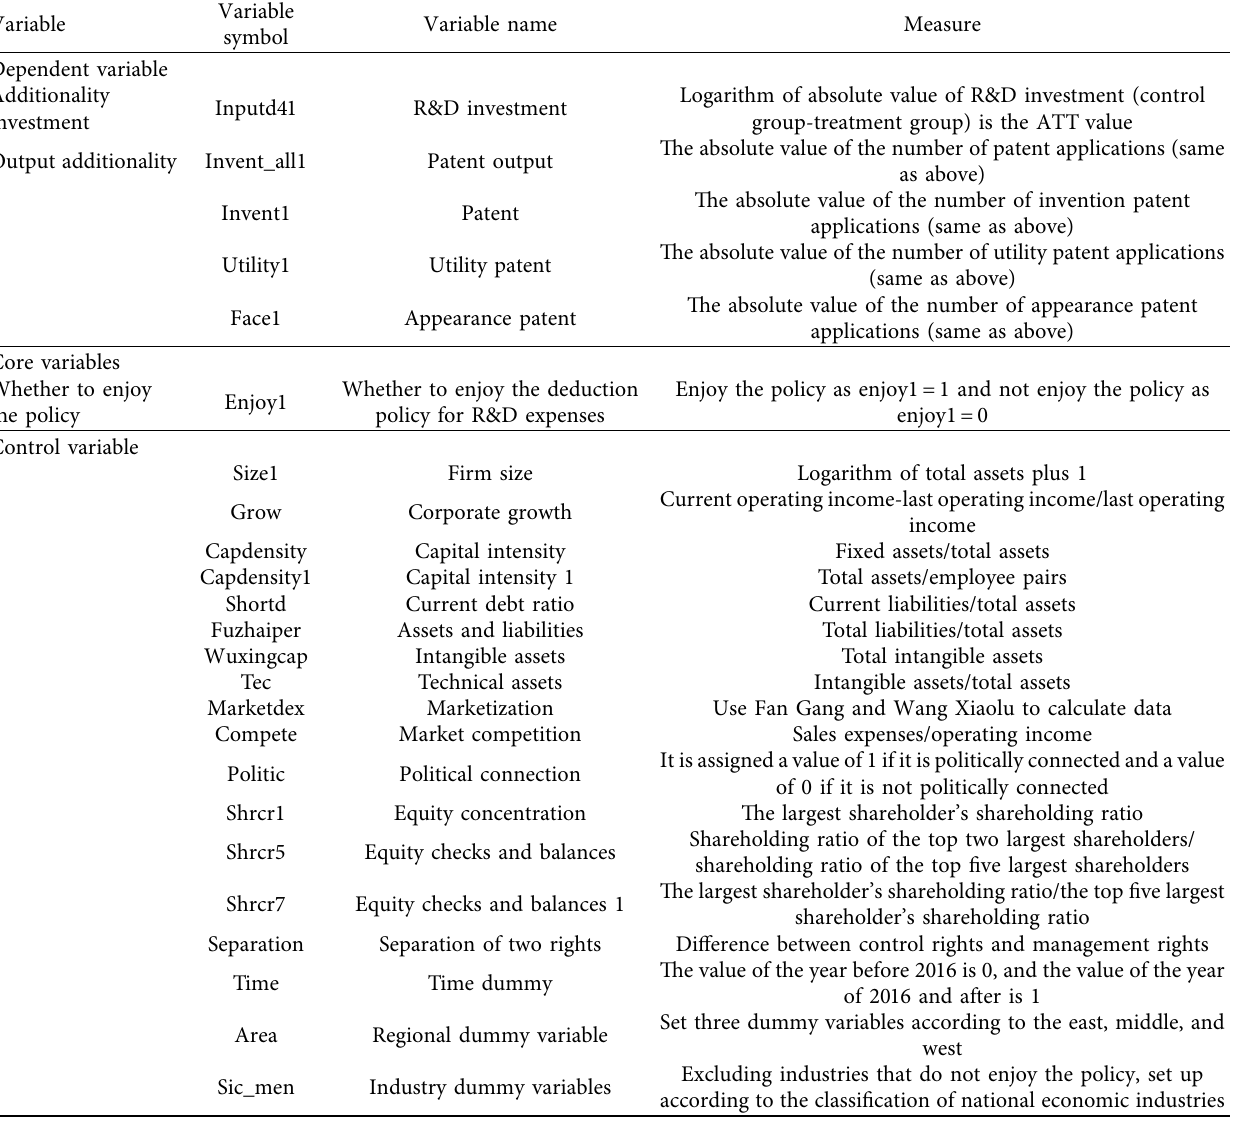
Table 2: Variable description table.